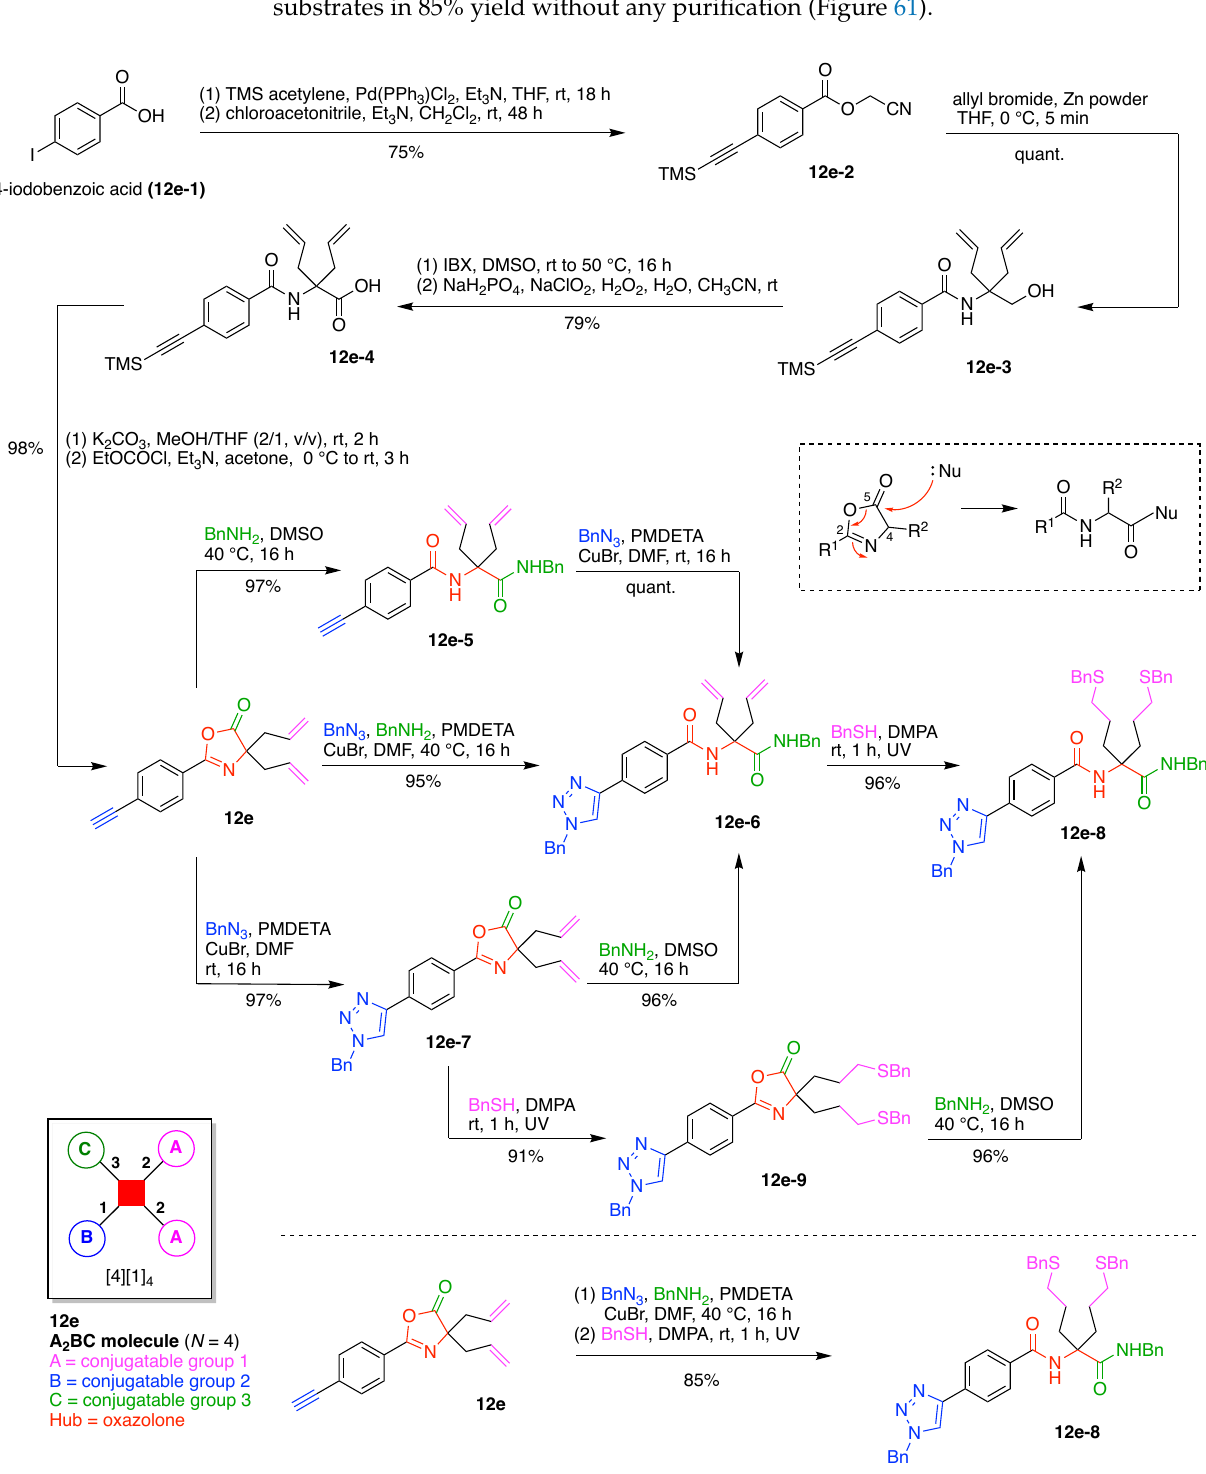
Figure 61. An oxazolone for multiple couplings ( lower left ). The ring-opening reaction of the oxazolone with a nucleophile ( insert in box ). Synthesis of a heteromultifunctional oxazolone scaffold ( top ). Reactivity of the scaffold towards aminolysis, Cu-catalyzed click reaction, and thiol-ene click reaction ( bottom ).